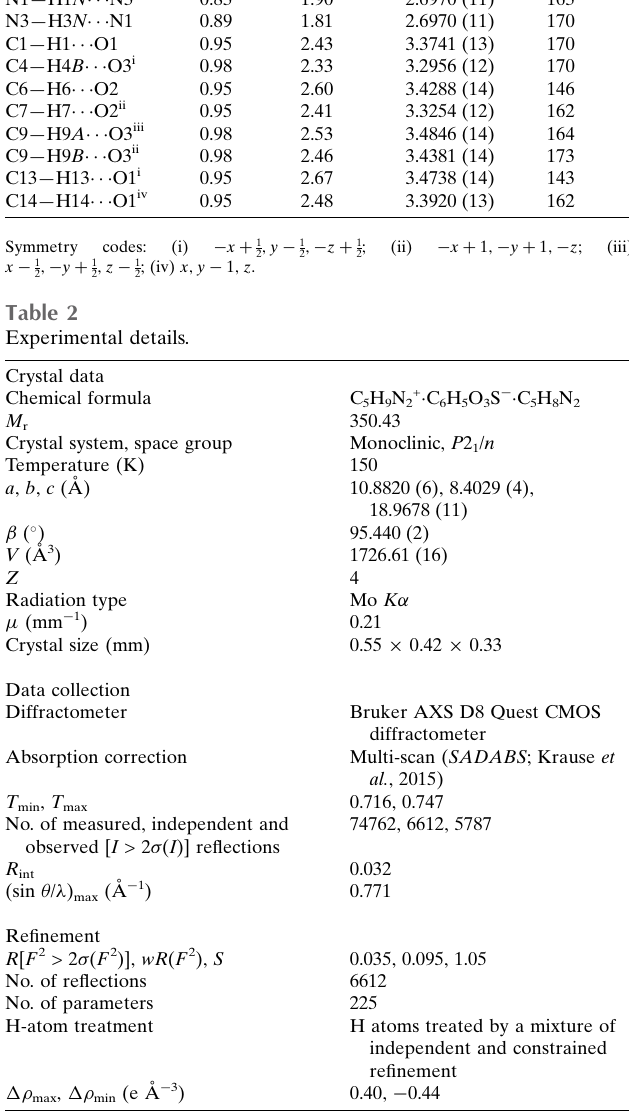
Table 1 Hydrogen-bond geometry (A˚ , (cid:5) ).